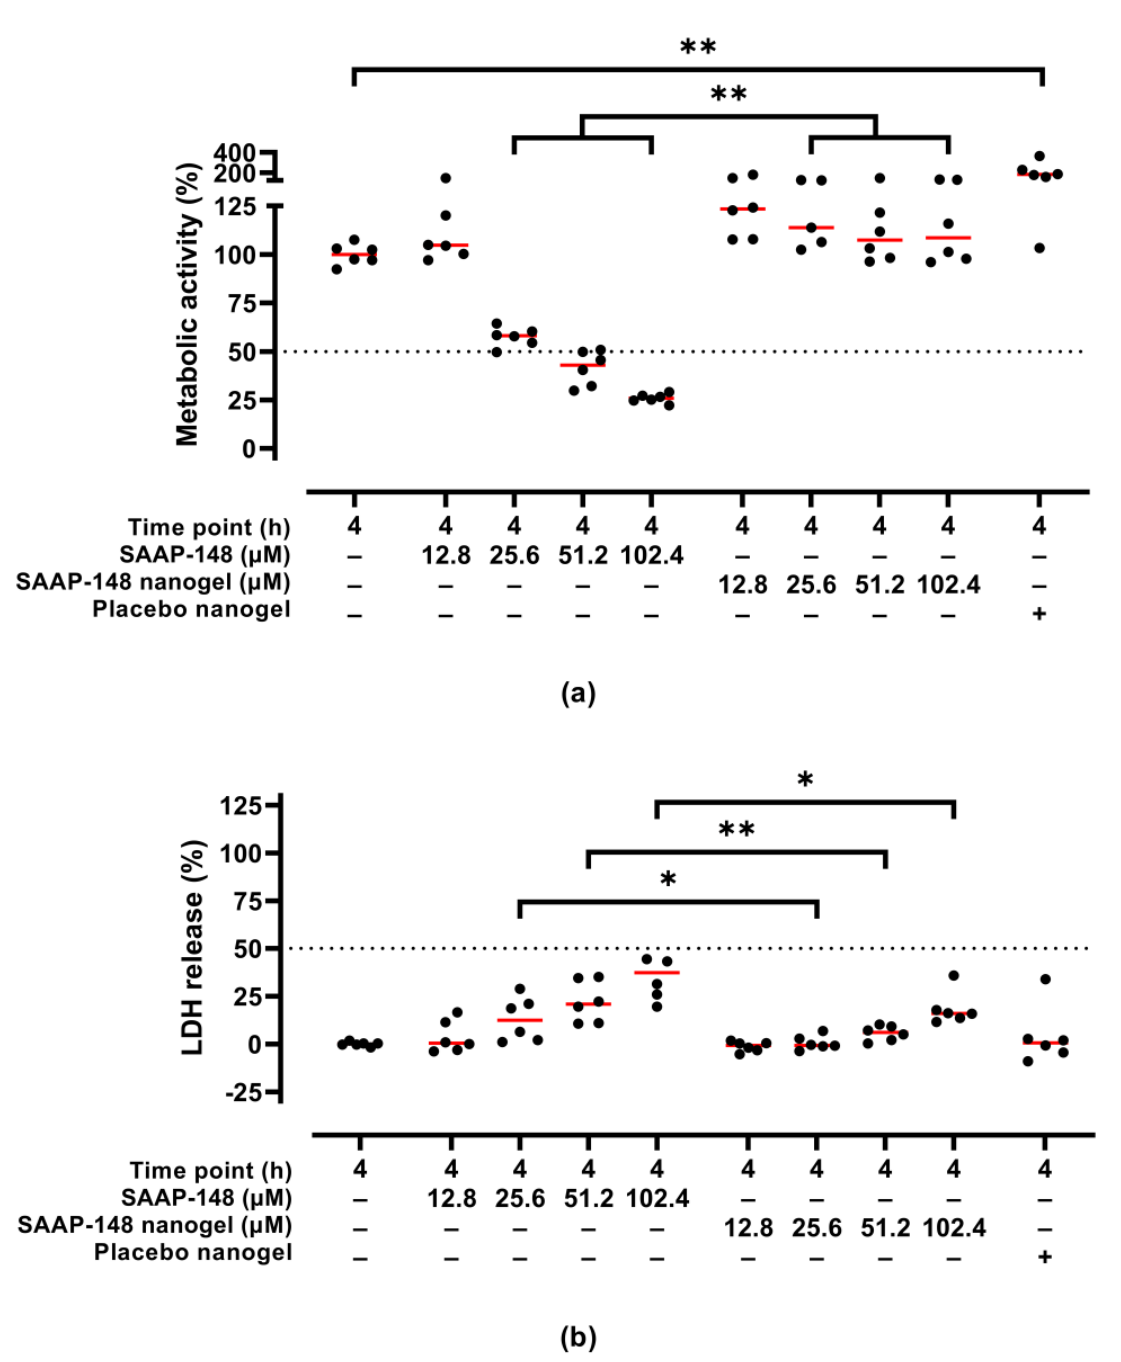
Figure 4. Cytotoxic activities of redispersed PVA-lyophilized SAAP-148-loaded nanogels to a 3D human epidermal model compared to SAAP-148 and placebo nanogels . The 3D human epidermal model was exposed for 4 h to SAAP-148, SAAP-148 nanogel or placebo nanogel in PBS. The cells in